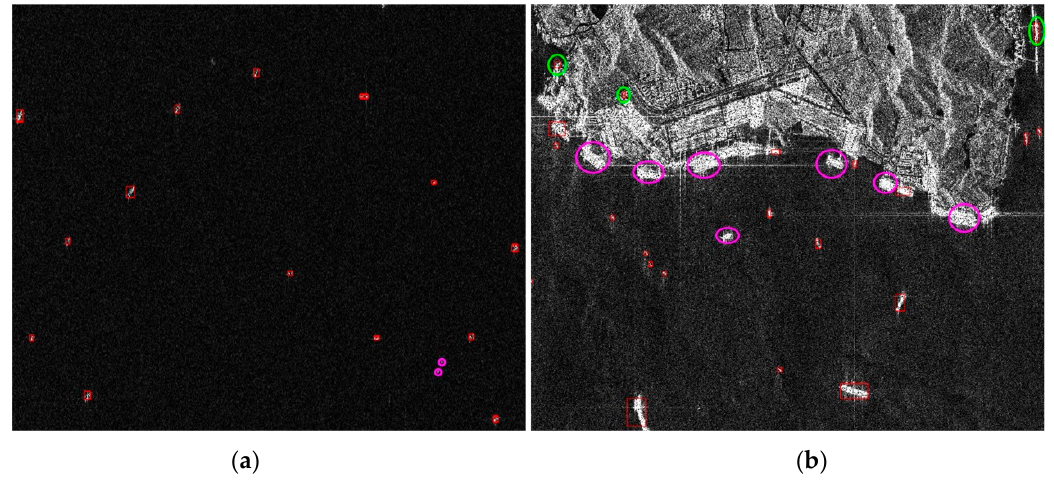
Figure 9. The experimental robustness of the RetinaNet for ship detection in the ( a ) Ocean and ( b ) Harbor: The red rectangles, green ellipses, and magenta ellipses indicate the detected ships, false alarms, and the missing ships by the model.